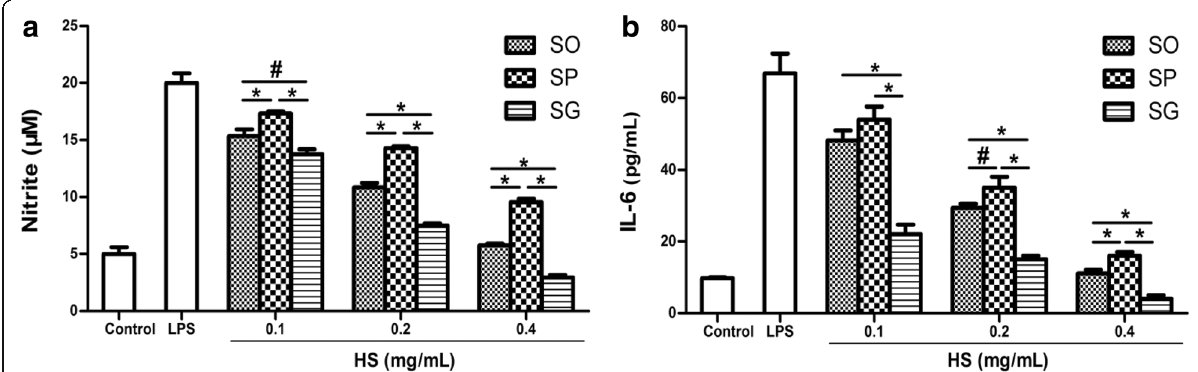
Fig. 5 Dose-dependent effects of 50% ethanol HS (SO, SP and SG) extracts on production of NO and IL-6. a Effects on NO production. b Effects on IL-6 production. Cells were treated with three concentrations (equivalent to 0.1, 0.2 and 0.4 mg herb/mL) of individual HS extract for 1 h and then treated with 100 ng/mL LPS for another 24 h. NO production was determined as in Fig. 4. IL-6 production was determined by ELISA. Data are shown as mean ± SD from tree independent experiments. # p < 0.05, * p <